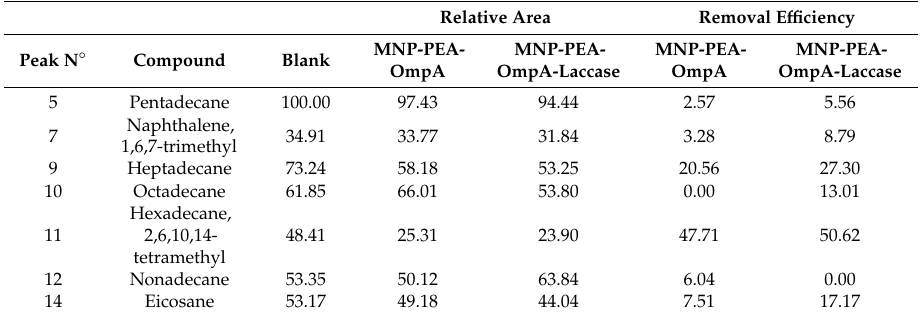
Table 2. Changes in composition for the selected compounds present in O / W samples after treatment with the